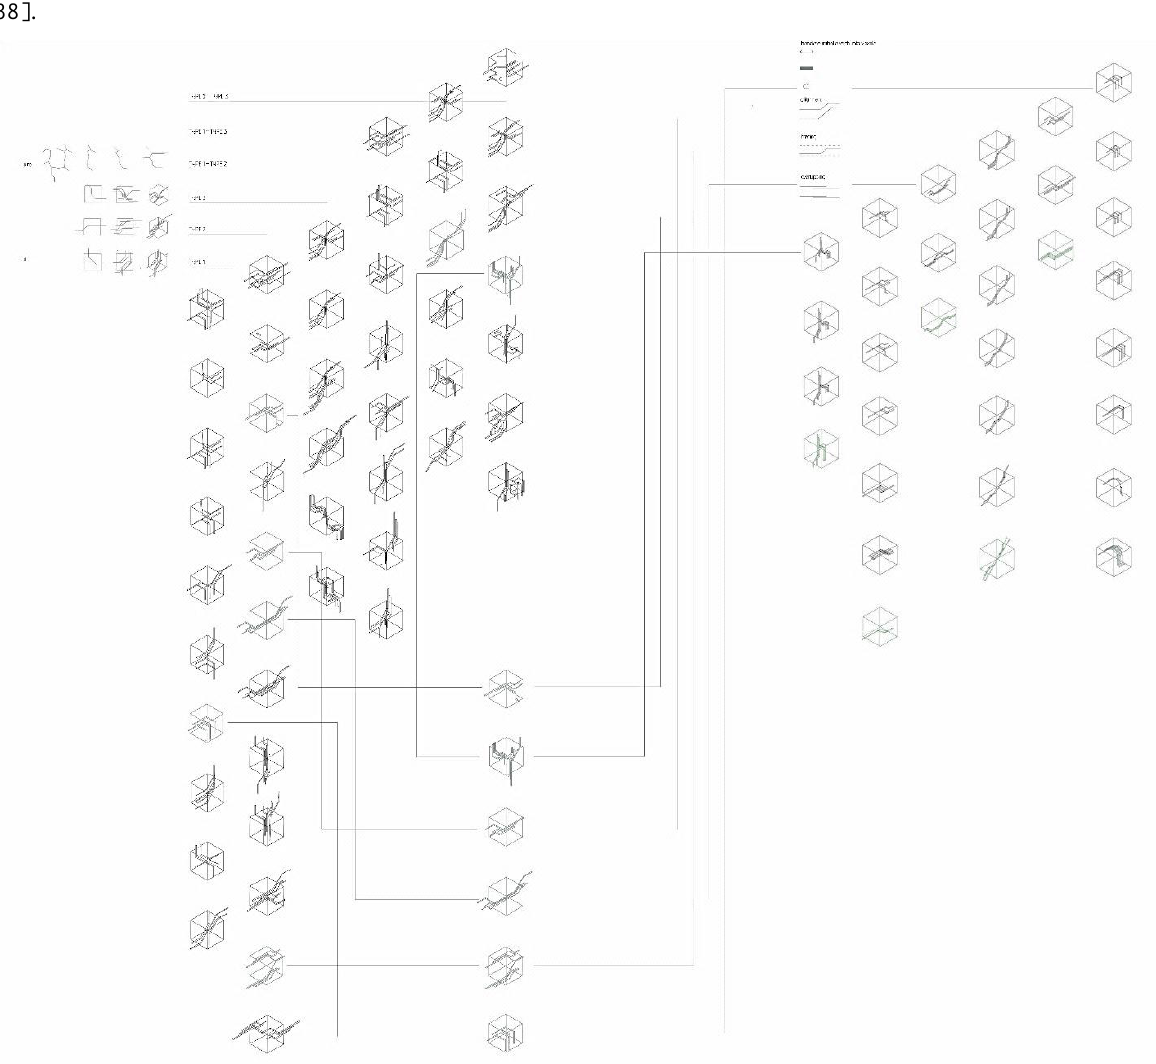
Figure 7. Analogical method that relies on a precise initial investigation of the respective models, objectives and